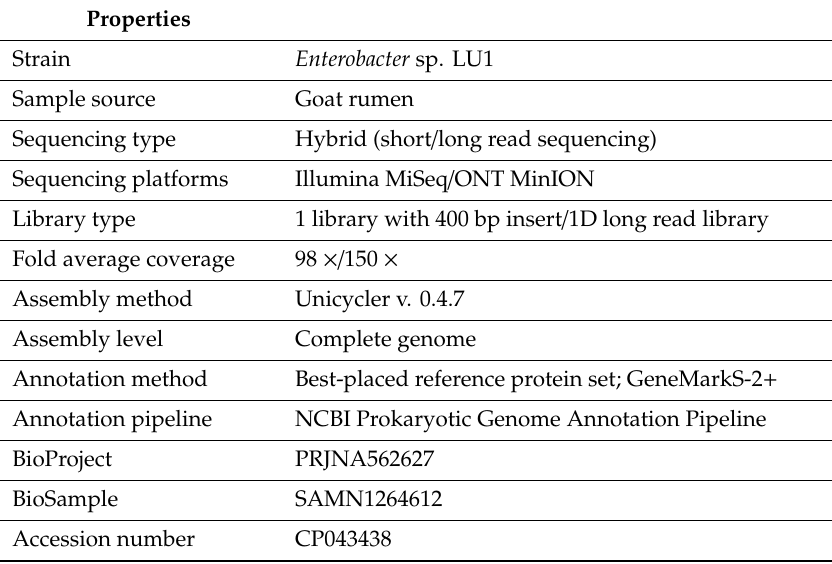
Table 1. General information on genome sequencing project of Enterobacter sp.